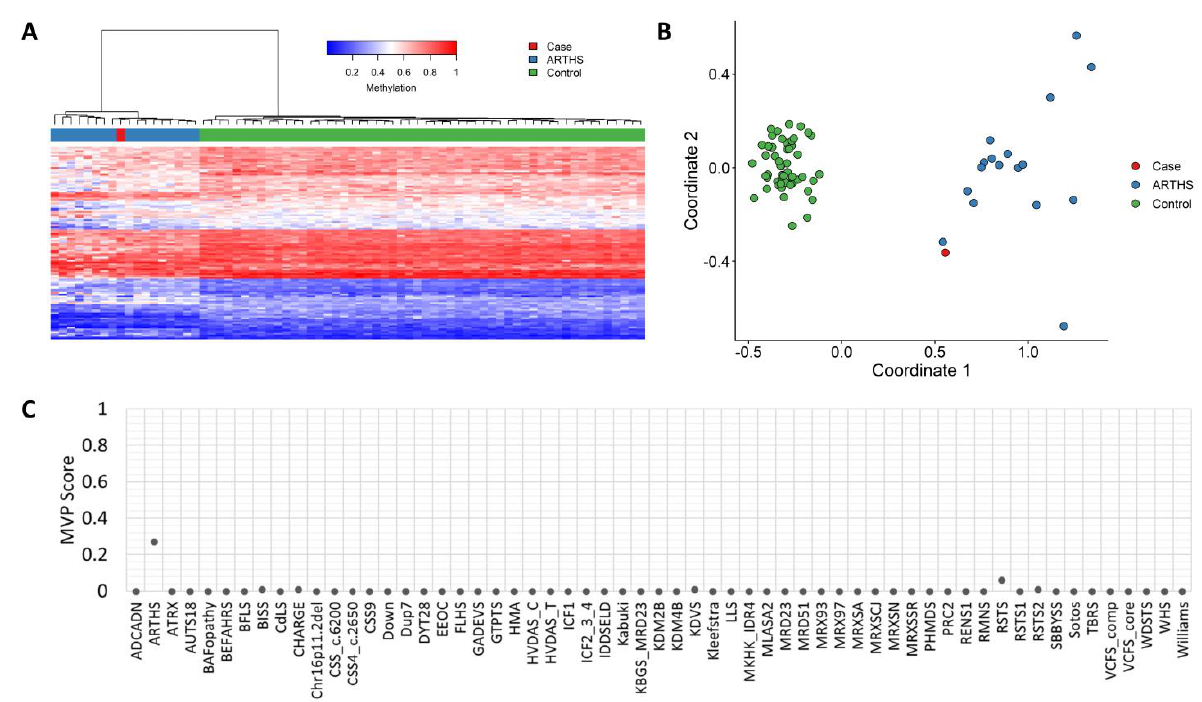
Figure 3. EpiSign (DNA methylation) analysis of peripheral blood from a patient with a pathogenic nonsense KAT6A variant, the causative gene for Arboleda-Tham syndrome 1. A. Euclidean hierar- chical clustering (heatmap); each column represents a single case or control, and each row represents one of the CpG probes selected for the episignature. B. multidimensional scaling plot shows segre- gation of patient (red) has a DNA methylation signature similar to that of subjects with a confirmed ARTHS episignature (blue) and distinct from controls (green), confirming robustness of the ep- isignature. C. MVP score, a multi-class supervised classification system capable of discerning between multiple episignatures by generating a probability score for each episignature. The elevated patient score for ARTHS suggests an episignature similar to the ARTHS reference (see Methods section for methylation analysis).